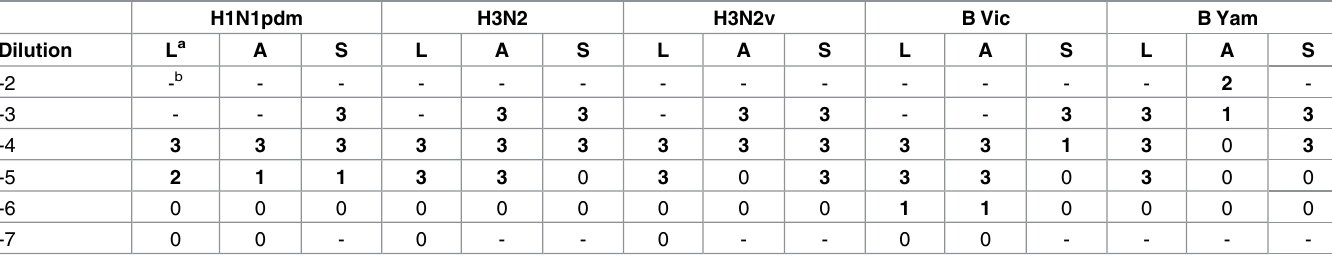
Table 6. Serial dilutions of viruses in SRS in the Simplexa, Liat, and Alere assays.